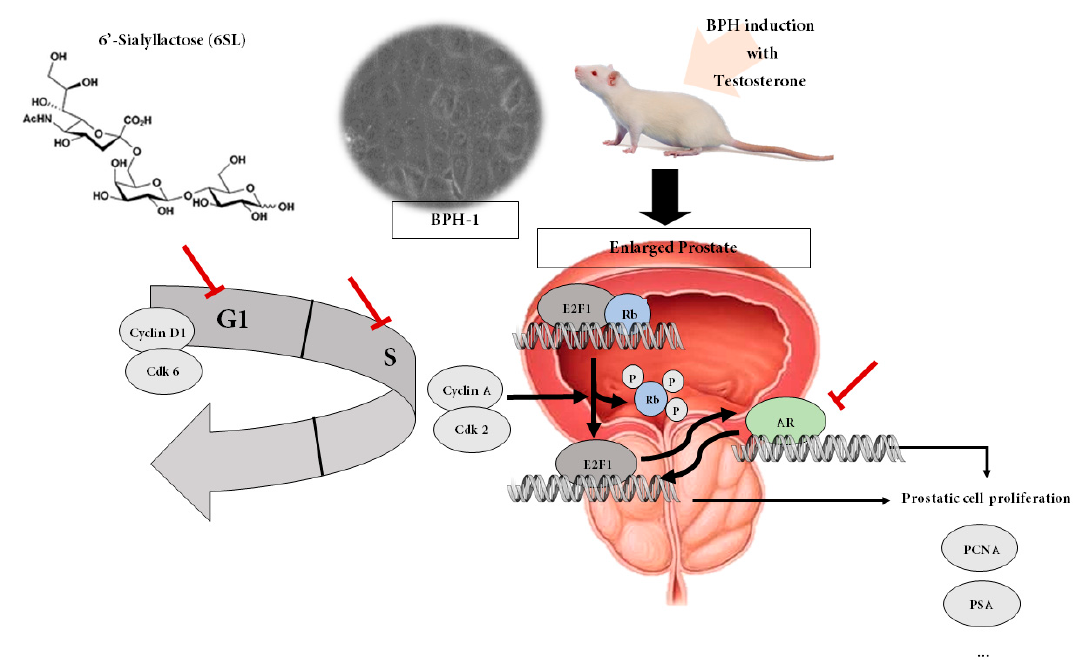
Figure 6. Proposed action mechanism of 6SL in TP-induced BPH rats and BPH-1 cells. 6SL demonstrated anti-proliferative e ff ects in a testosterone-induced BPH rat model and on BPH-1 cells